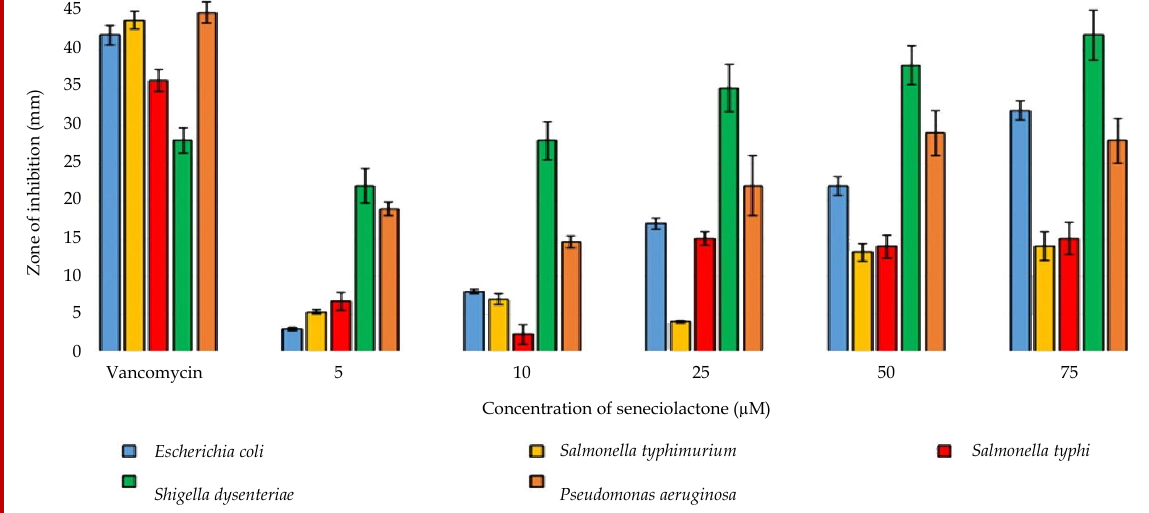
Figure 2: Seneciolactone shows a wide-range of antibacterial effect against the five tested bacterial strains. Effect of different con- centrations of seneciolactone on the zones of inhibition (antibacterial effect) of the several tested bacterial strains. Shigella dysenteri- ae was the most susceptible pathogenic bacteria at all tested doses